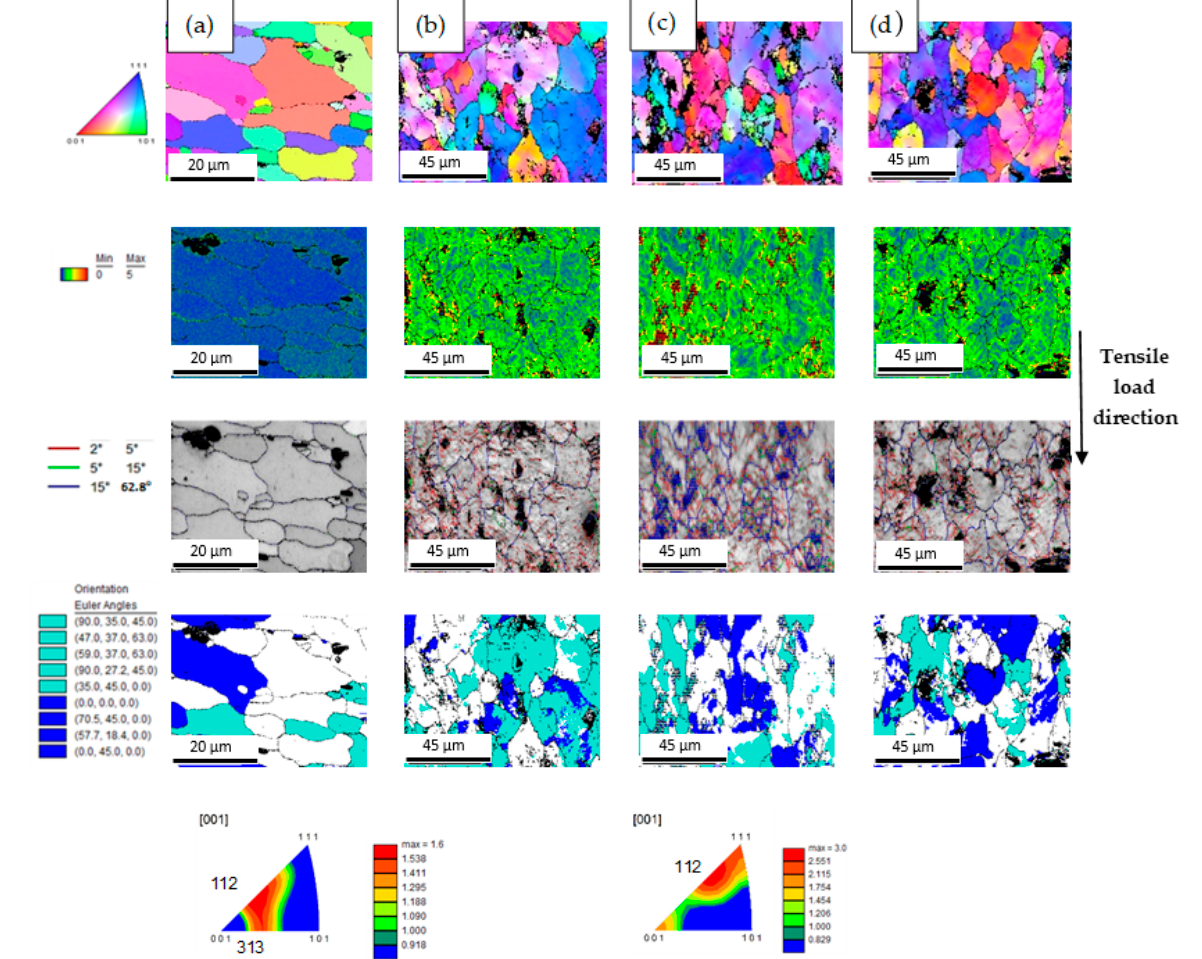
Figure 12. EBSD scans and respective maps for sample ( a ) rx.AR, ( b ) rx. RD, ( c ) rx.45 and ( d ) rx.TR. Table 6. KAM values, misorientation, and texture components of the recrystallized sheet sample. rx.AR rx.RD rx.45 rx.TR